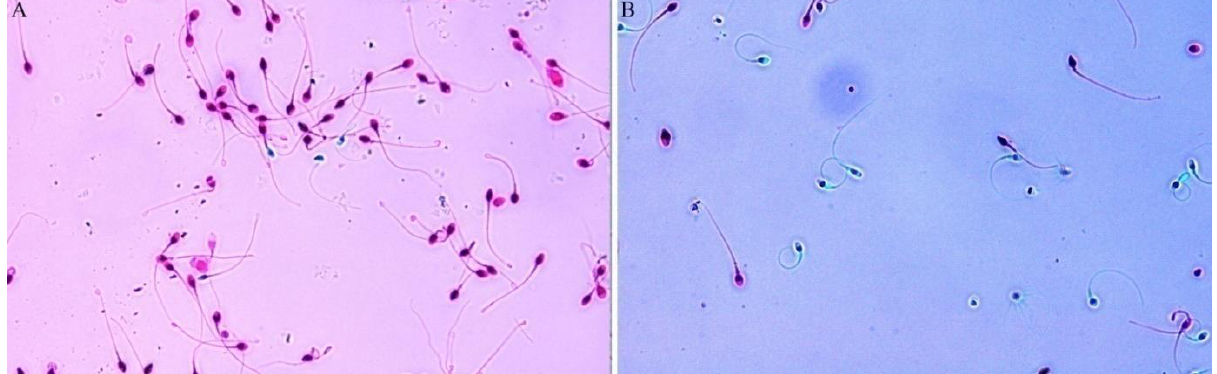
Figure 2. Sperm vitality ( A ) before and ( B ) after magnetic-activated cell sorting. Cells were labelled with eosin dye. Dead spermatozoa became red and viable spermatozoa remained colorless.